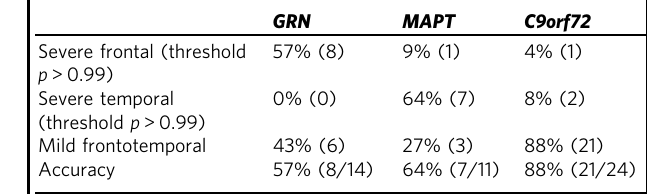
Each entry is the percentage (number) of participants of a particular genotype assigned to that subtype.The fi nal rowindicates the percentage (fraction)of participants assignedtothe correct subtype from each genotype. The results show that SuStaIn can accurately discriminate genotypes, validating the ability of SuStaIn to identify distinct phenotypes that align with known